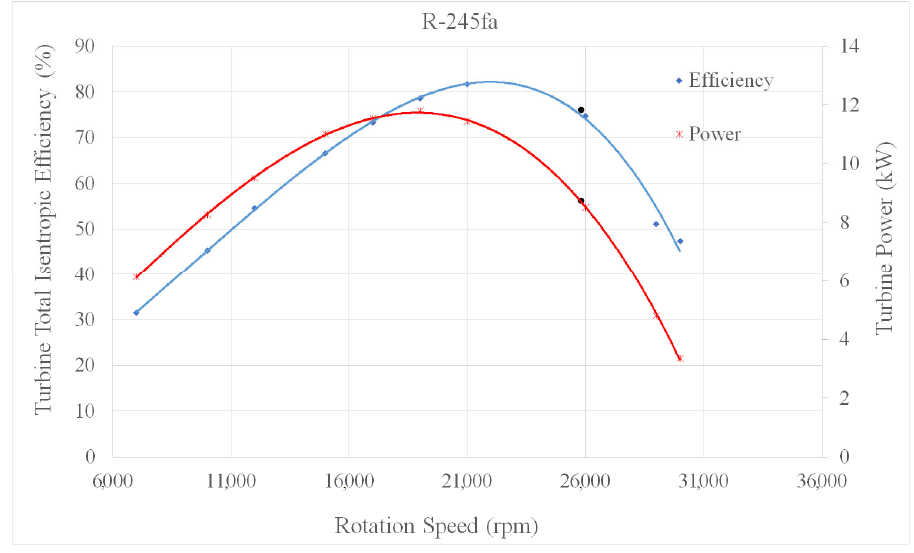
Figure 14. Variation in the total isentropic efficiency and power of the turbine operating with R-245fa, as a function of rotation speed.